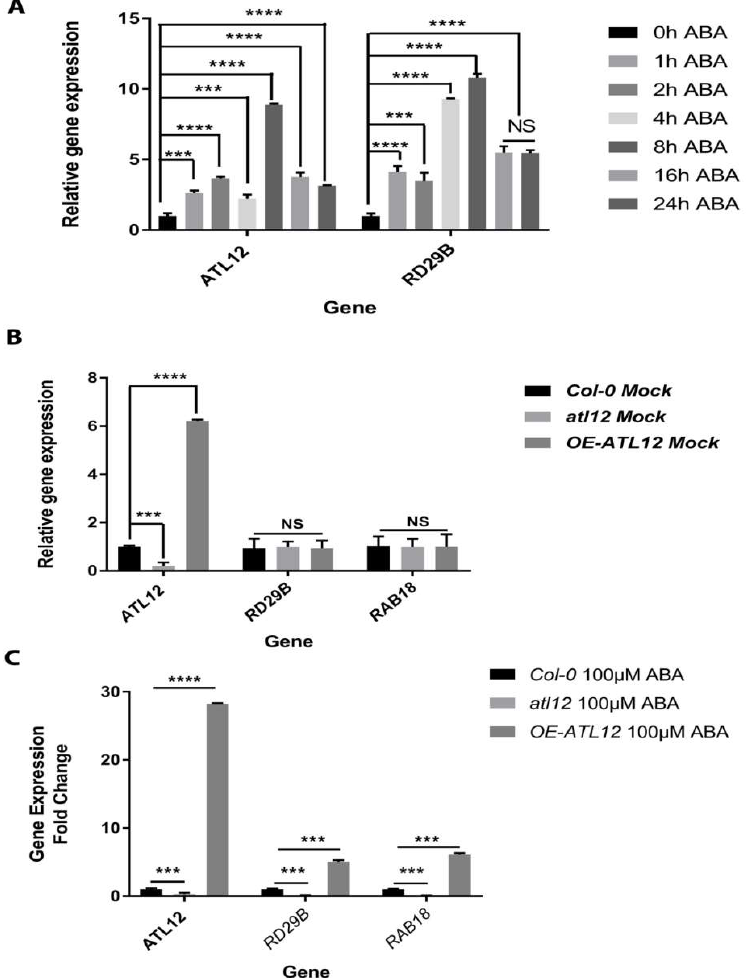
Figure 6. Expression pattern of ATL12 and RD29B in response to ABA. ( A ) qRT-PCR analysis of ATL12 , and RD29B mRNA expression in response to salt at different time points. ( B ) qRT-PCR analysis of ABA-responsive gene RD29B and RAB18 expression in Col-0, atl12 , and overexpression ATL12 line under normal conditions in response to ABA. ( C ) qRT-PCR analysis of ABA-responsive gene RD29B and RAB18 expression in Col-0, atl12 , and overexpression ATL12 line in response to ABA. Asterisks indicate statistically significant differences between the samples, according to the One-way ANOVA analysis and multiple comparison post-Tukey’s test. NS: no significance; ***: p < 0.001, ****: p < 0.0001.